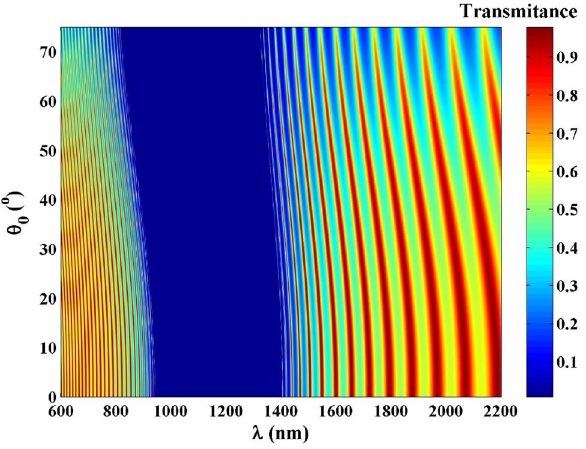
Figure 1. The colour map for the PC design ( AB ) 30 for TM